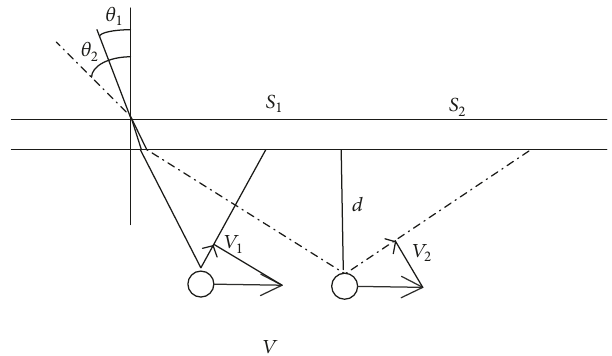
Figure 9: Influence of the reflection angle on measurement.